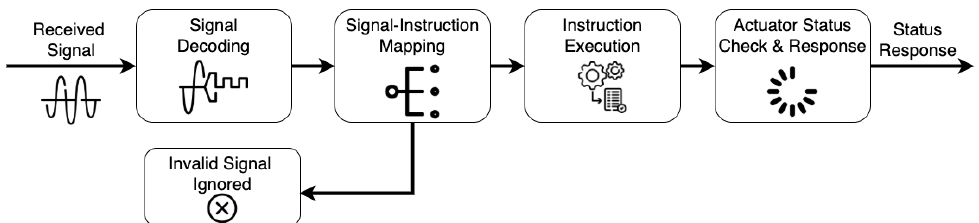
Figure 6. Block diagram of the processes in the perception/sensing layer. The received signals go through signal decoding, signal-to-instruction mapping, instruction execution with invalid signals ignored, and actuator status check and response.